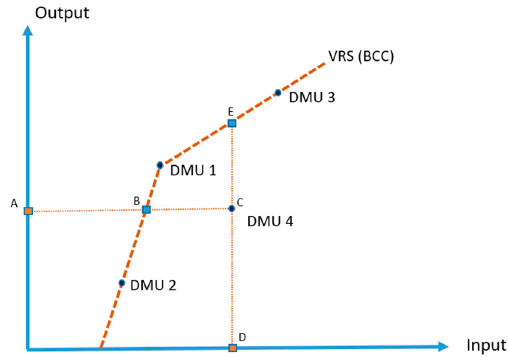
ffi ciency frontier and DMU 4 e ffi Figure 4. DEA VRS efficiency frontier and DMU 4 efficiencies. Figure 4. DEA VRS e Figure 4. DEA VRS efficiency frontier and DMU 4 efficiencies.